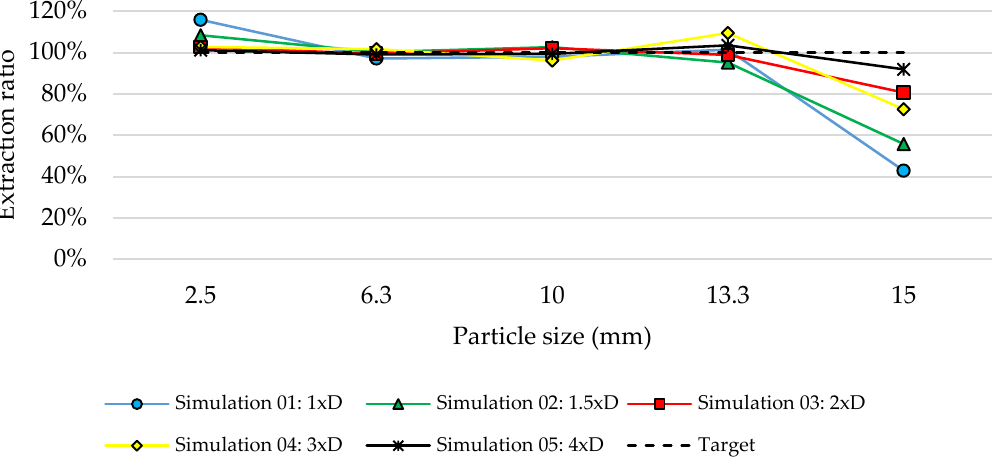
Figure 6. Extraction in cross-stream cutter as function of the cutter aperture.